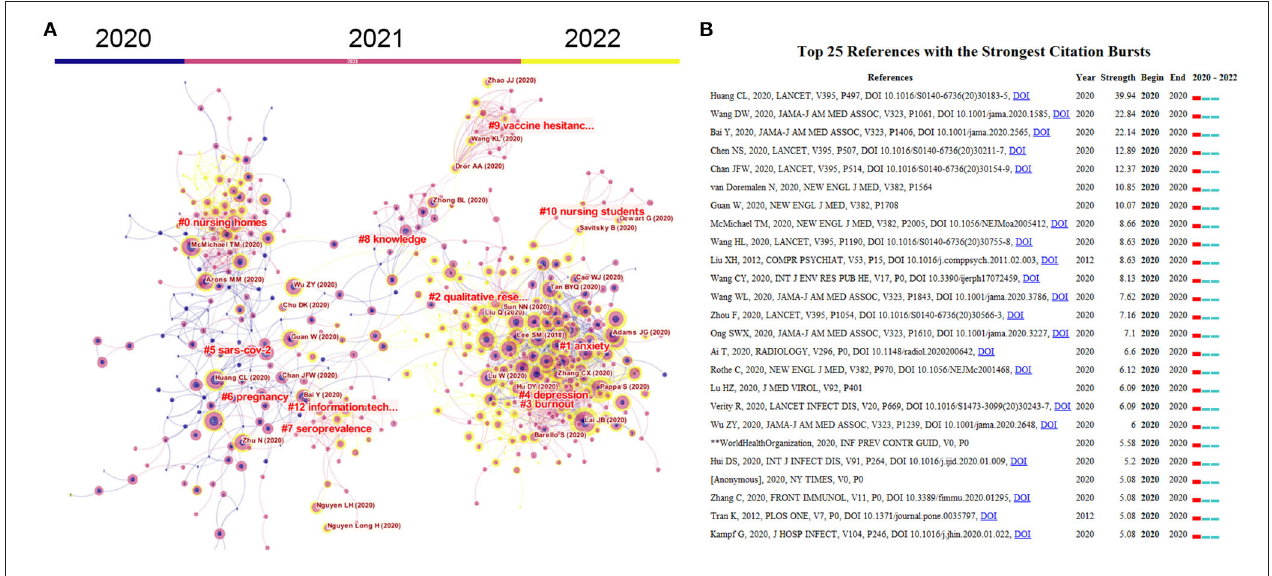
FIGURE 6 | (A) Reference co-citation network clustered by CiteSpace. The nodes and links are distinguished by colors, in which dark color refers to an earlier co-citation relationship. References with at least 100 citations are displayed in the network in nodes named by the first author (publication year). The size of the node is positively associated with the citation number. The red writing reports the name of the cluster auto-identified by the Citespace LLR algorithm. (B) Top 25 references with the strongest bursts. The red bar indicates the burst duration. The burst strength suggests the importance of this article to the research